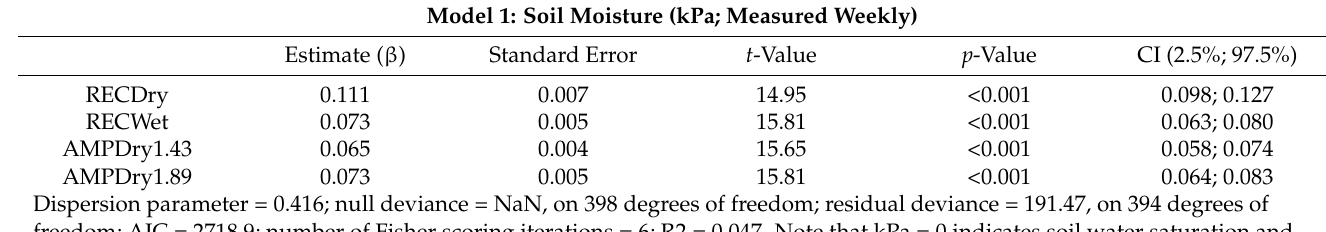
Table 2. Estimated regression parameters, standard errors, coefficients and p -values for 2 gamma